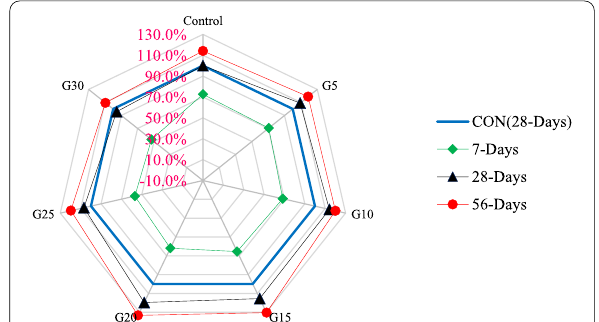
Fig. 8 Relative compressive